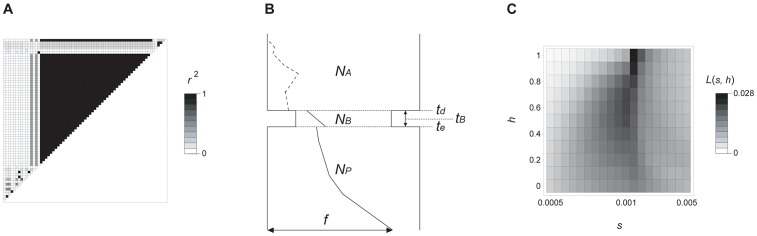
Molecular evolutionary analysis of prol1.1.(A) Pattern of pairwise linkage disequilibrium (r2) between 67 SNPs in maize landraces, including 13 class-M and 2 class-T haplotypes. (B) Likely demographic model of the process of maize domestication (see Text S2 for details). The ancestral (wild) and current population sizes of maize are denoted by NA and NP, respectively. The domestication bottleneck started at td generations ago, and ended at te generations ago. NB and tB represent the size and duration of the bottleneck, respectively. The trajectory of class-M haplotype is shown by dashed (neutral in the wild population) and solid (positively selected after domestication) lines. f represents the current frequency of class-M haplotype in maize. (C) Heat map of the maximum likelihood estimates of the intensity of selection (s) and the degree of dominance (h). The likelihood given s and h is denoted by L(s, h), and the scale bar is also shown.